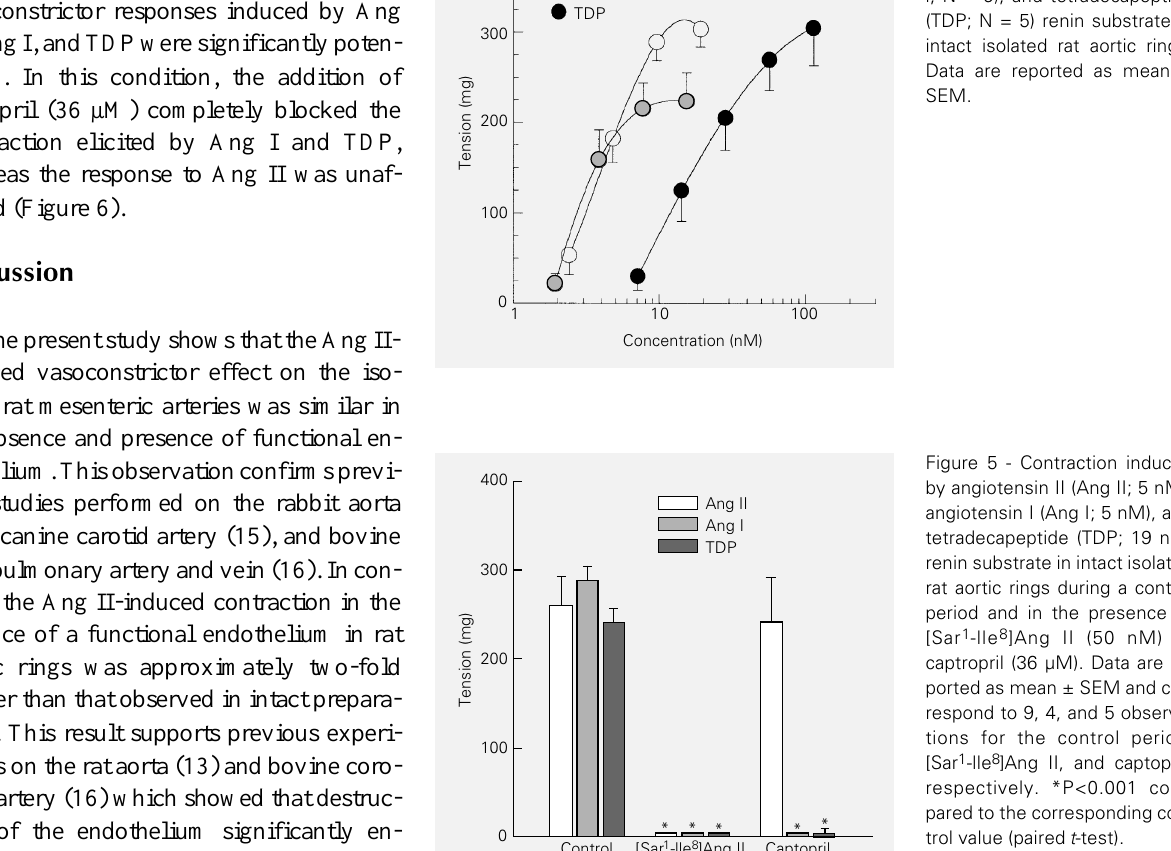
Figure 4 - Concentration-re- sponse curves for angiotensin II (Ang II; N = 7), angiotensin I (Ang l; N = 9), and tetradecapeptide (TDP; N = 5) renin substrate in intact isolated rat aortic rings. Data are reported as mean – SEM.